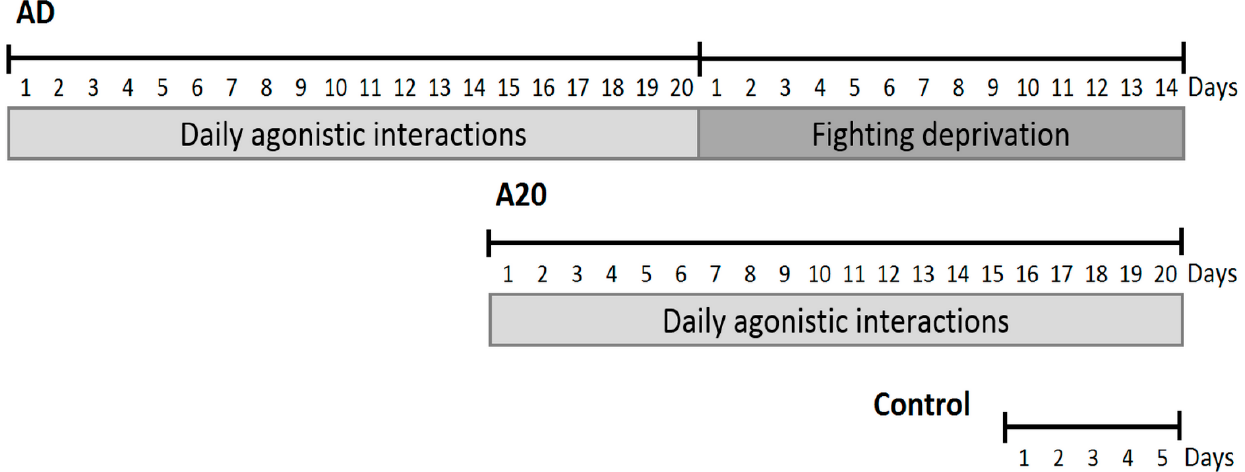
Figure 1. Timescale of the experiment. A20 are the mice with 20-day repeated aggression accompanied by wins in daily agonistic interactions; AD, A20 aggression-deprived mice after 14 days of fighting deprivation; control, mice without consecutive agonistic interactions.